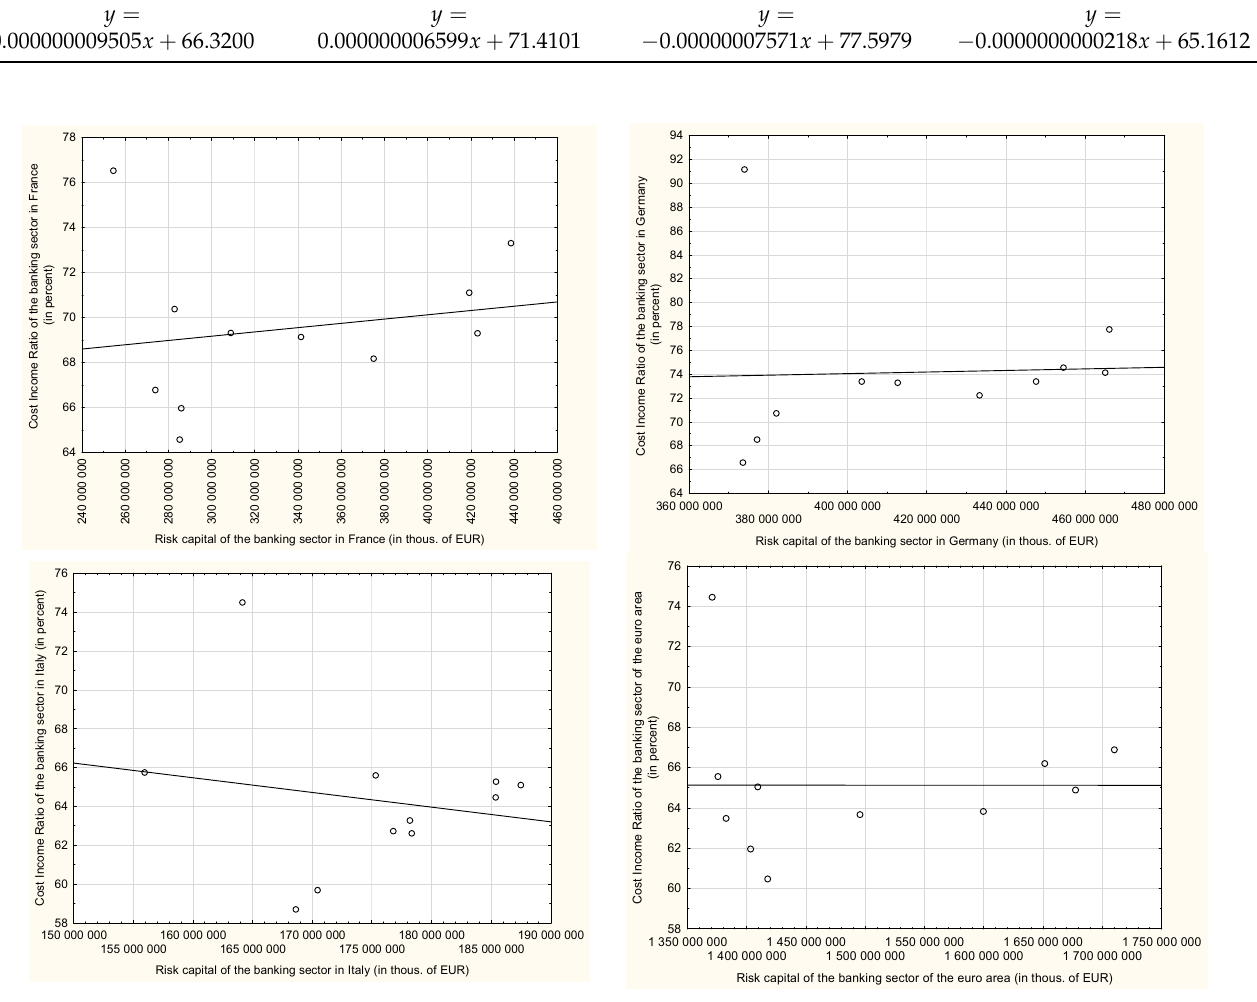
Figure 6. Two-dimensional scatterplots of stage 3 (source: own work).